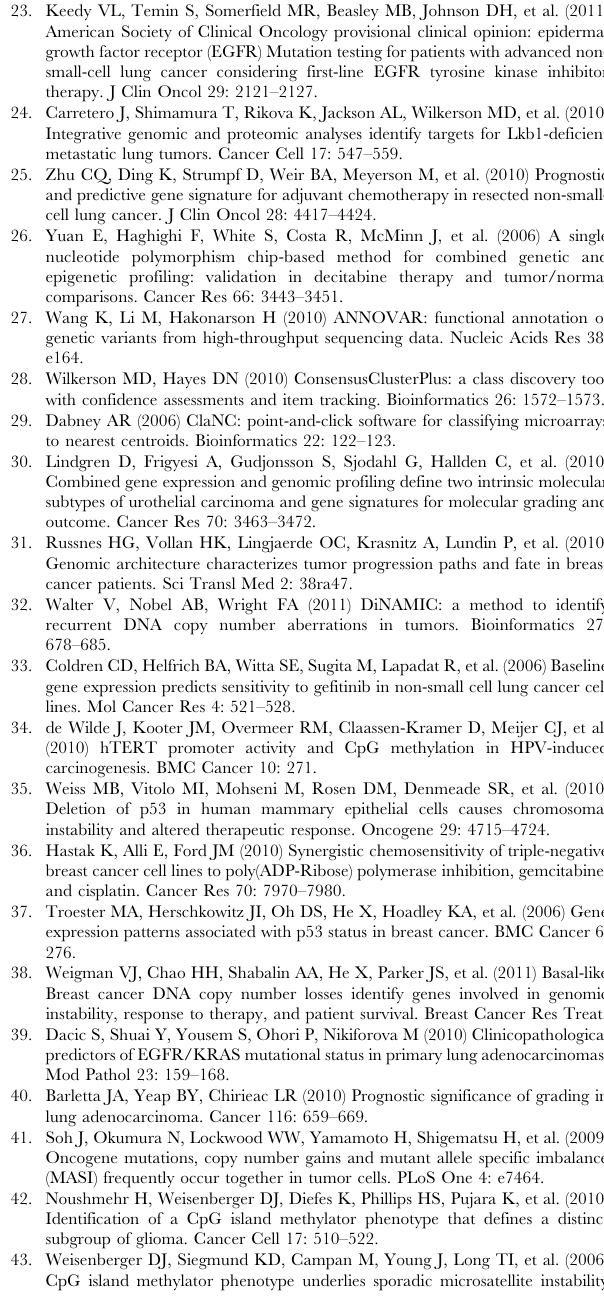
to the point of the most extreme CN, and left and right refer to the region’s boundaries. Positions are hg 18 genomic coordinates. Table S8 Differentially methylated site totals. Cells contain the number of sites with significantly greater methylation in the row class compared to the column class. Methylation was compared between classes by Wilcoxon rank-sum tests that evaluated the null hypothesis of not greater methylation in the row class (Benjamini-Hochberg adjusted P , 0.05). For example, 11,720 sites had significantly greater methylation in Magnoid tumors compared to normal lung. Squamoid and Bronchioid hypermethylated sites compared to normal lung were almost